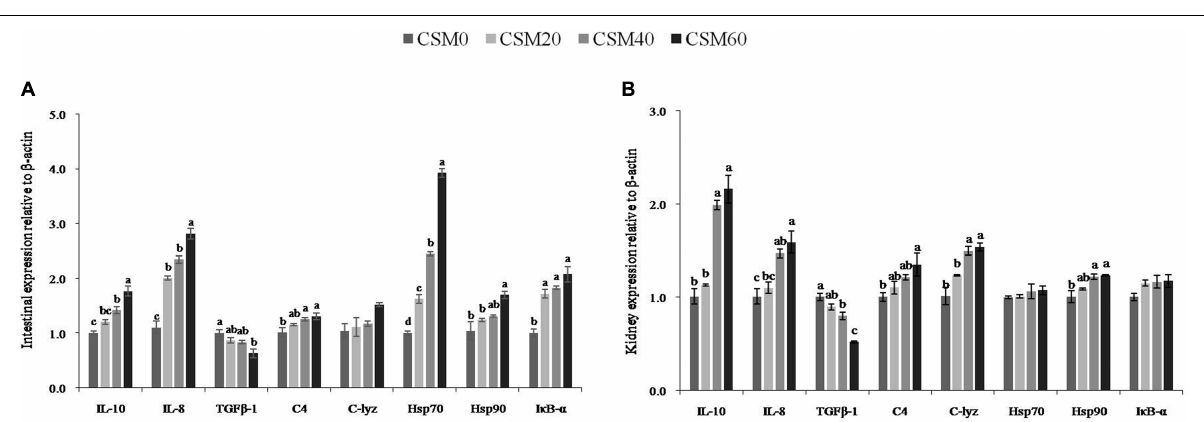
FIGURE 5 | mRNA expression levels of the key regulators in immune response after juvenile golden pompano ( Trachinotus ovatus ) fed with CSM0, CSM20, CSM40 and CSM60 diets, respectively. (A) Intestine. (B) Kidney. Values with different superscripted small letters mean significant difference ( P < 0.05). IL-10, interleukin 10; IL-8, interleukin 8; TGF β -1, transforming growth factor β 1; C4, complement 4; C-lyz, c-type lysozyme; Hsp70, heat shock protein 70; Hsp90, heat shock protein 90; I κ B- α , NF-kappa-B inhibitor